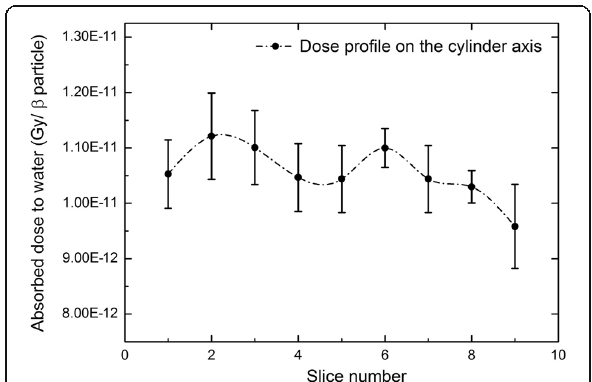
Fig. 8 Profile of the absorbed dose to water per emitted beta particle on the cylinder axis, as calculated by Raydose. Voxel-by-voxel absorbed dose calculations were performed using the acquisition in anthropomorphic geometry reported in Fig. 2k. VOIs the size of a TLD (4.5 mm diameter, 0.8 mm height) were drawn on the dose profile. The average absorbed dose per unit emitted beta particle was determined to be (1.06 ± 0.04) × 10 − 11